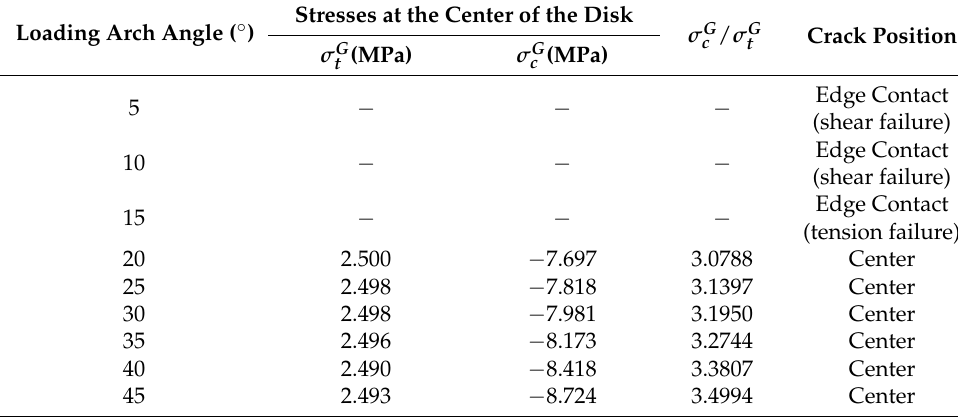
Table 4. Predicted stresses at the center of the disk and the initial position of the crack of Concrete tested by